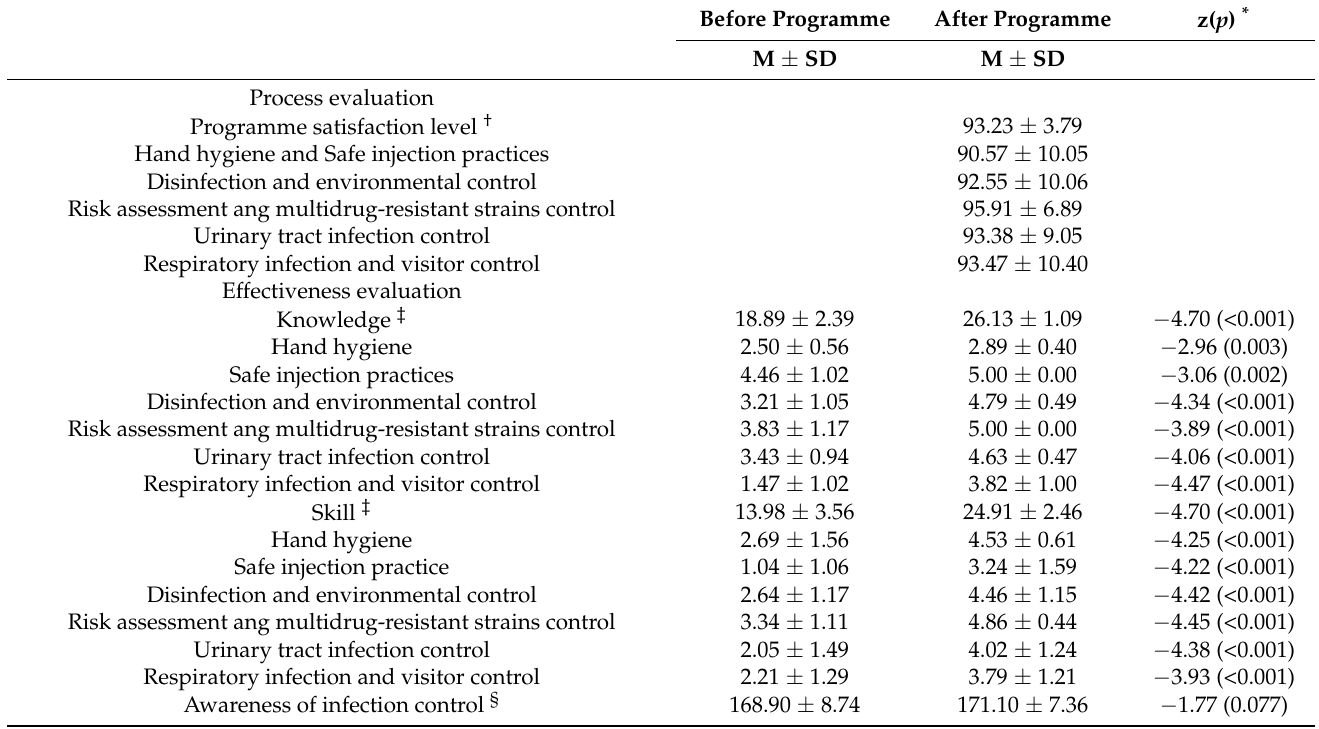
Table 4. Evaluation of educational-training programme for infection control practitioners in long-term care hospitals based on the DACUM method (N =